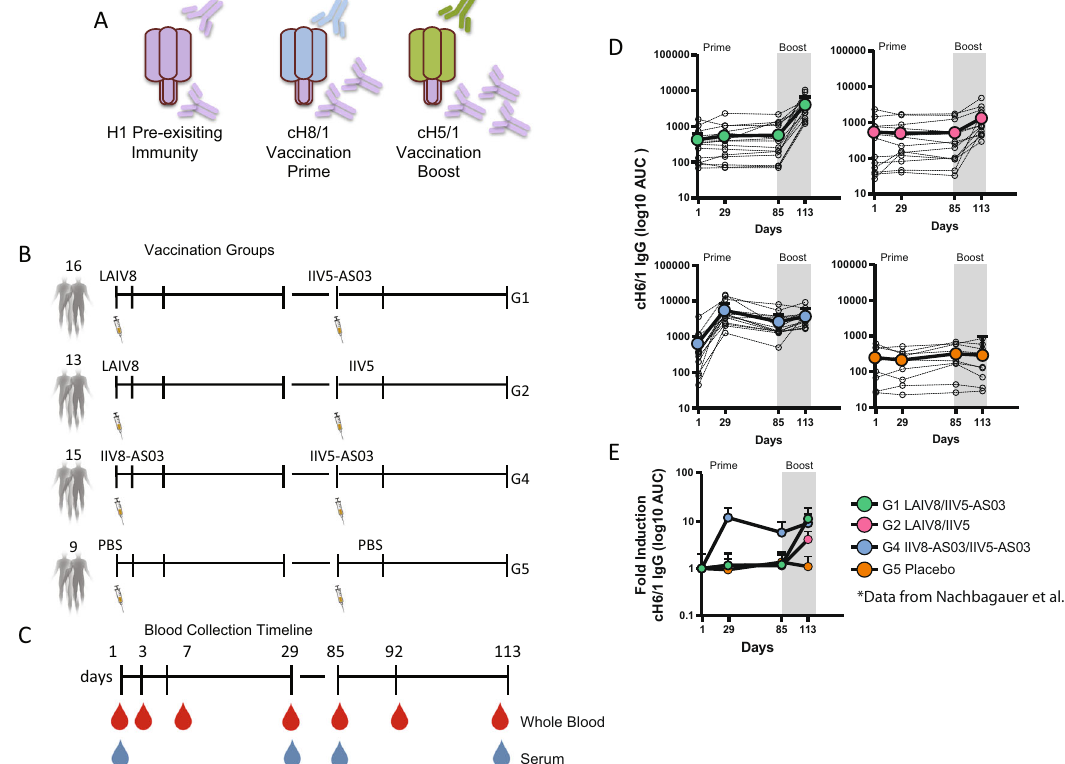
Fig. 1 Overview of design and experimental approach (CVIA057; ClinicalTrials.gov identi fi er NCT03300050). A Sequential cHA vaccination strategy and the different vaccination groups. B Study design including vaccination and blood collection timeline. Three different vaccination regimens as well as placebo group were included. Group 1 received cH8/1N1 LAIV on day 1 followed by AS03-adjuvanted cH5/1N1 IIV on day 85 (LAIV8-IIV5/AS03). Group 2 received the same vaccination regimen but with the booster vaccination nonadjuvanted (LAIV8-IIV5). Group 4 received adjuvanted cH8/1N1 IIV followed by adjuvanted cH5/1N1 IIV (IIV8/ AS03-IIV5/AS03). Group 5 served as placebo control group and received PBS intramuscularly twice (PBS-PBS). C Blood for transcriptomic pro fi ling was collected (indicated in red) at baseline (day 1), days 3, 7, and 29 post prime; and on day 85 (pre-boost), day 93 (day 7 post-boost), and day 113 (day 29 post- boost). Paired samples for antibody quanti fi cation (light blue) were collected only on days 1, 29, 85, and 113. D Serum anti-H1 stalk titers. IgG titers in the LAIV8-IIV5/AS03, LAIV8- IIV5, IIV8/AS03-IIV5/AS03, and the placebo groups against recombinant cH6/1 HA substrate are shown in Berstein et al. 5 and Nachbaguauer et al. 6 . The geometric mean titer (GMT, big dots) and con fi dence interval (CI 95%) are shown. E Fold induction during the longitudinal follow up is also shown. Geometric mean fold rise (GMFR, big dots) and con fi dence interval (CI 95%) are